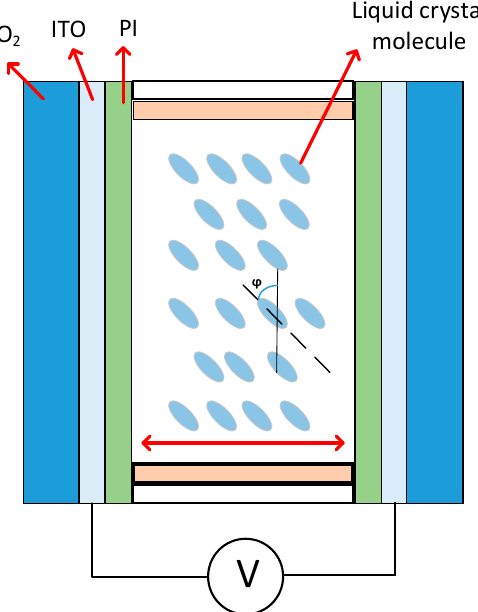
Figure 4. Schematic diagram of a typical liquid crystal adjustable phase delayer.